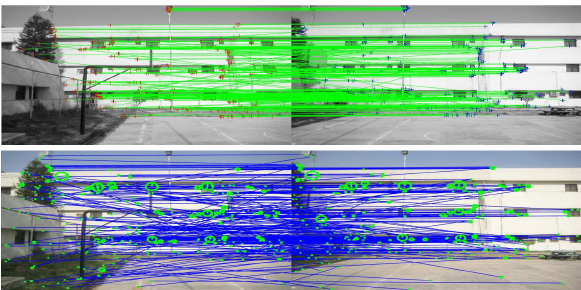
Figure 4. Matched keypoints by SURF (green) and SIFT (blue) operators in 1 st dataset